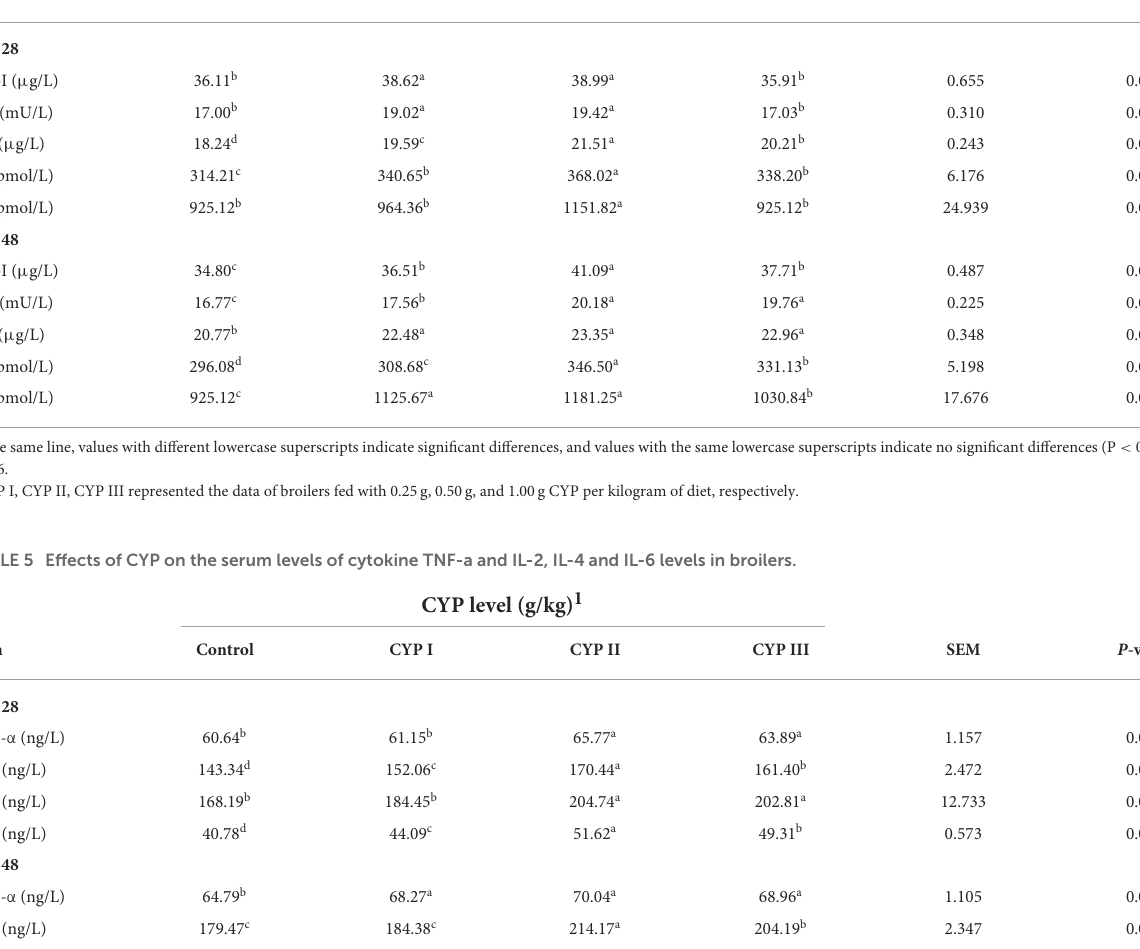
CYP level (g/kg) 1